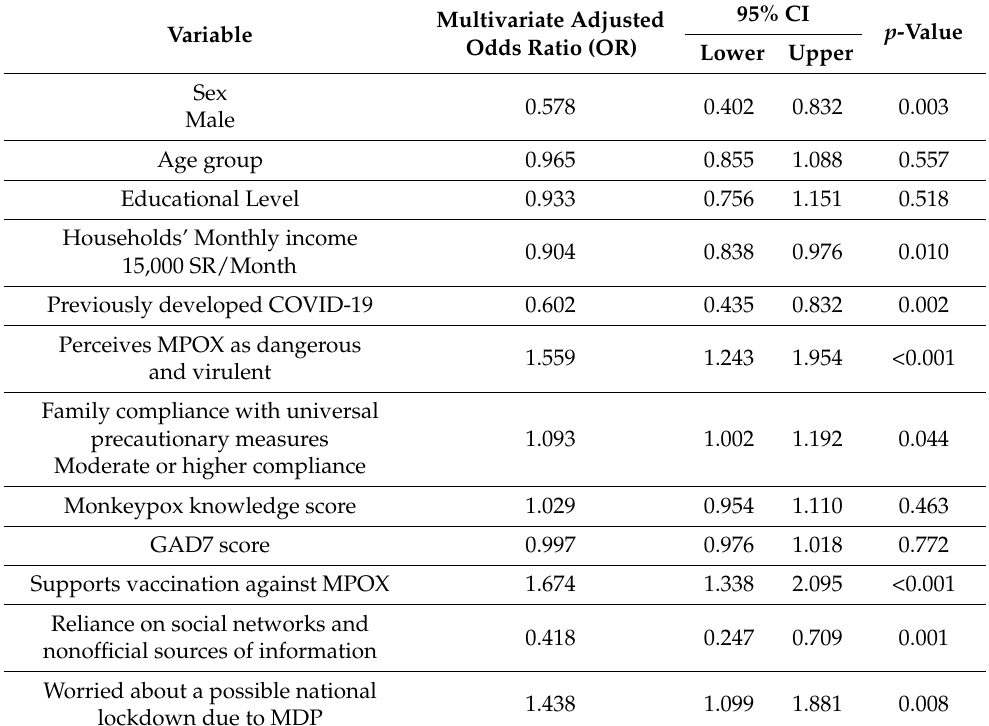
Table 2. Multivariate binary logistic regression analysis of the public’s variables associated with high odds of seeking more information about monkeypox. (KSA, 27 May to 5 June